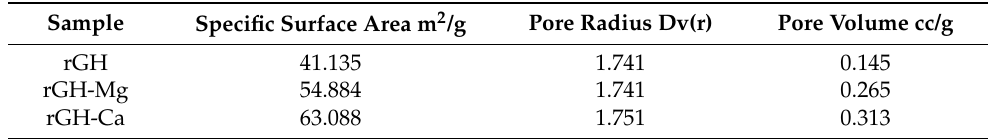
Table 4. Brunauer–Emmett–Teller (BET) surface area and textural properties of freeze-dried hydrogels.